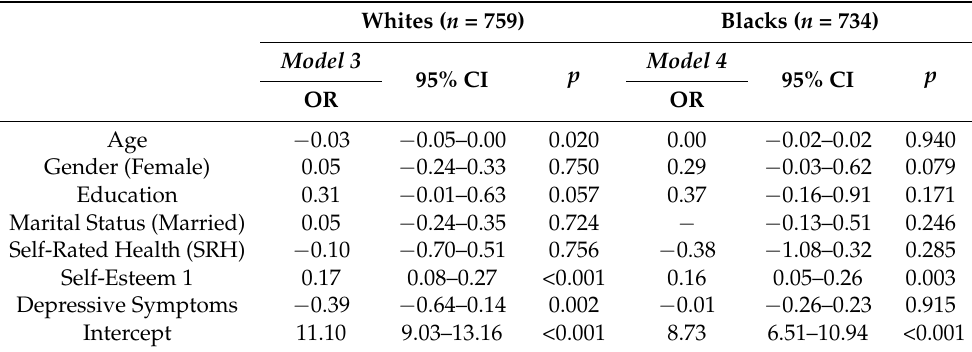
Table 4. Association between baseline depressive symptoms (2001) and subsequent change in self-esteem (2001–2004) using linear regression models among Whites and